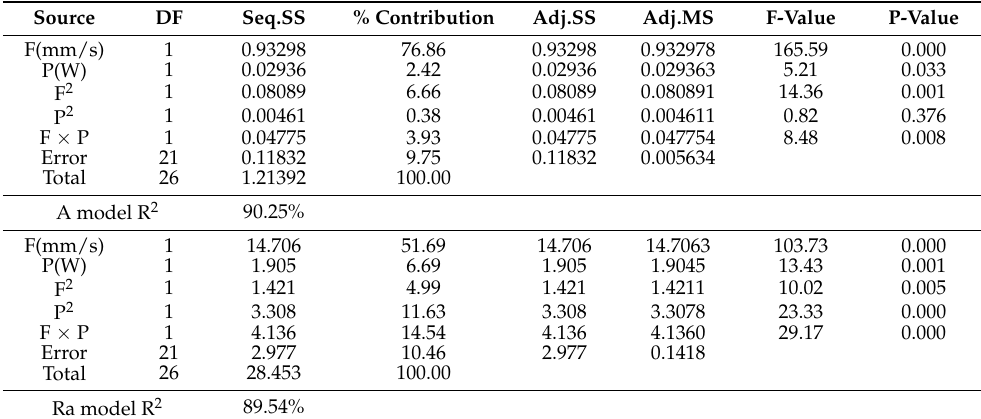
Table 3. ANOVA results for A and Ra regression